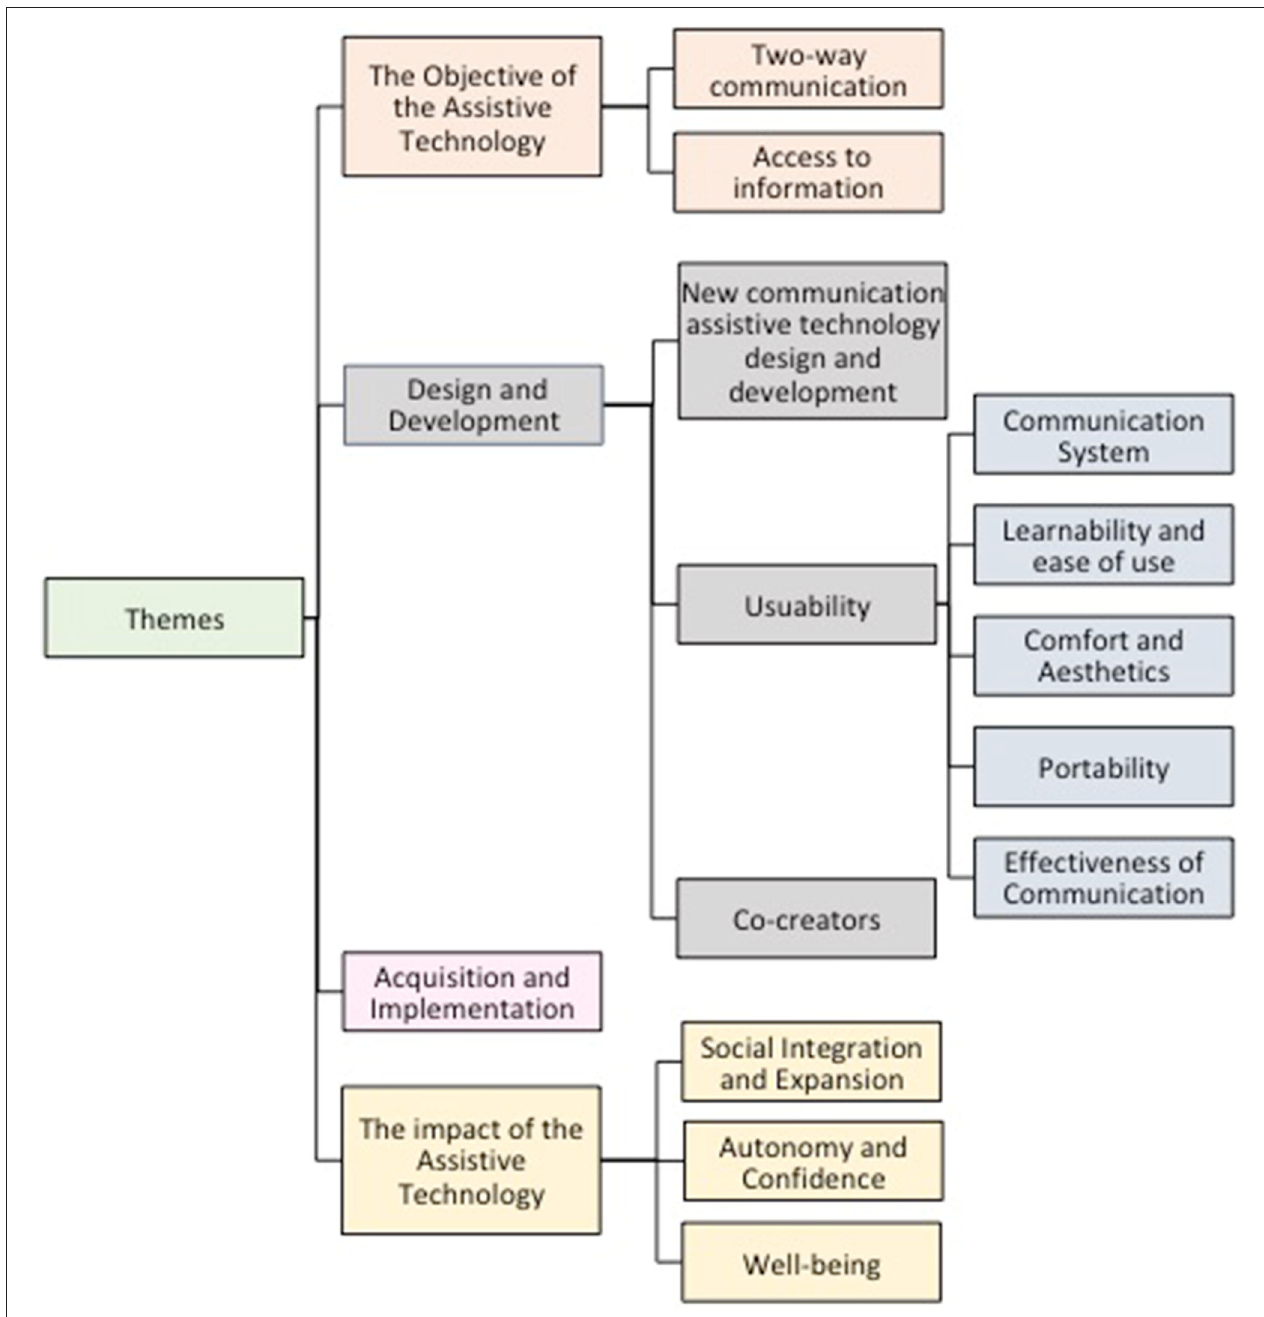
FIGURE 3 | Overview of the identified